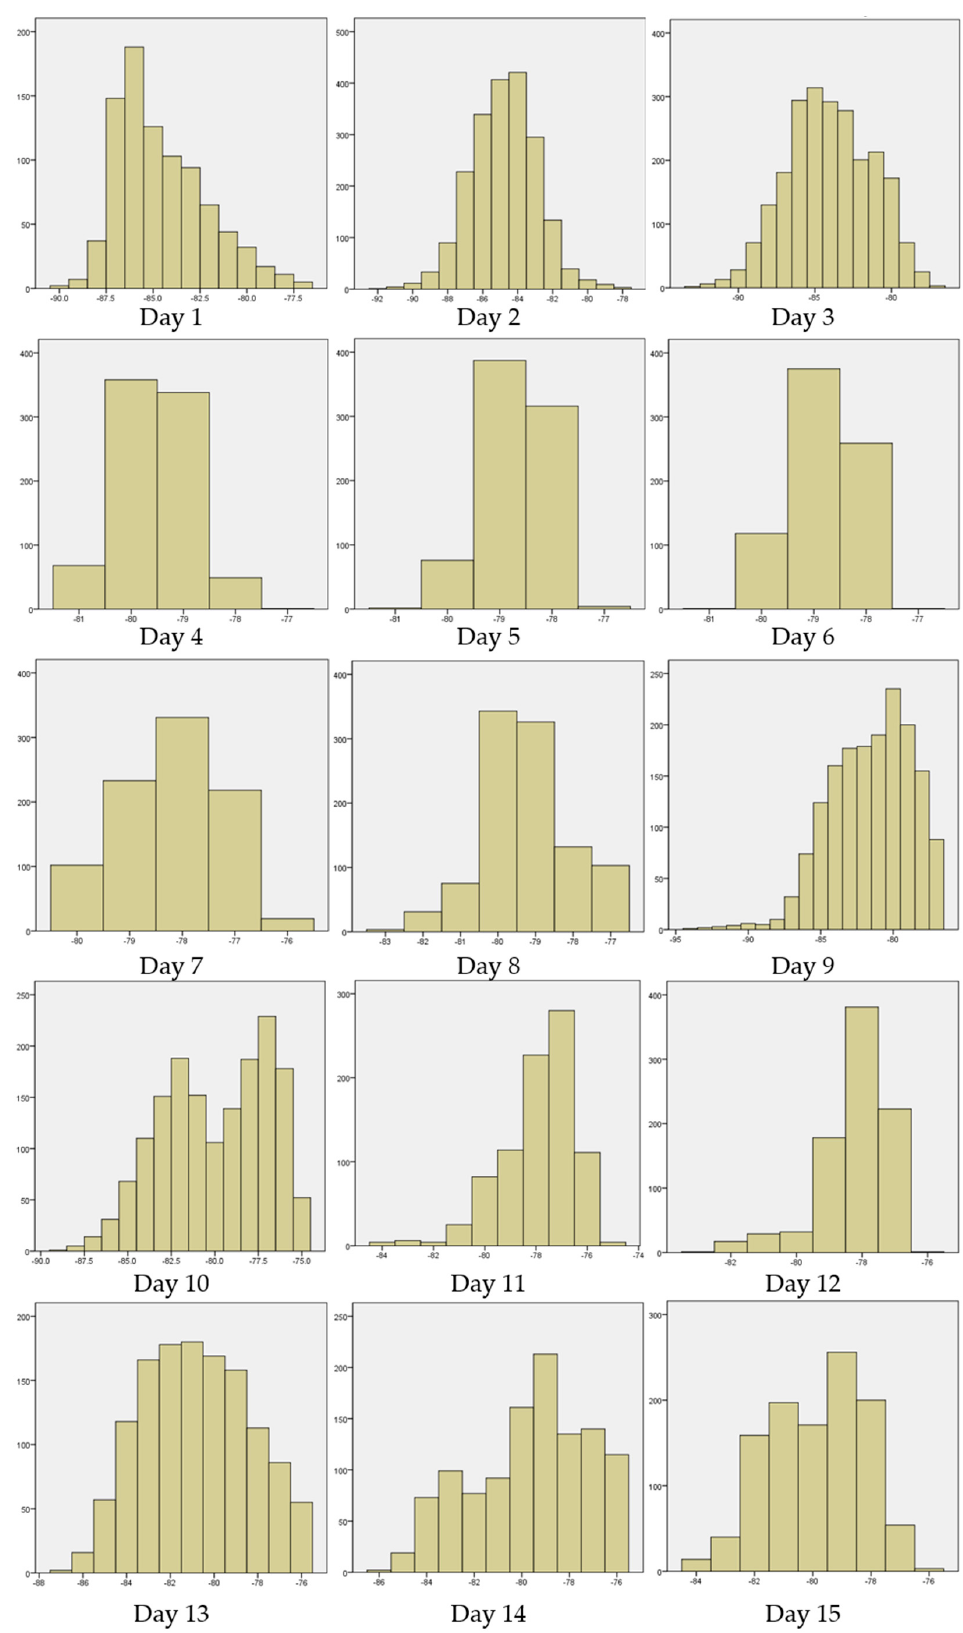
Figure A3. Histogram of signal strength on each day.